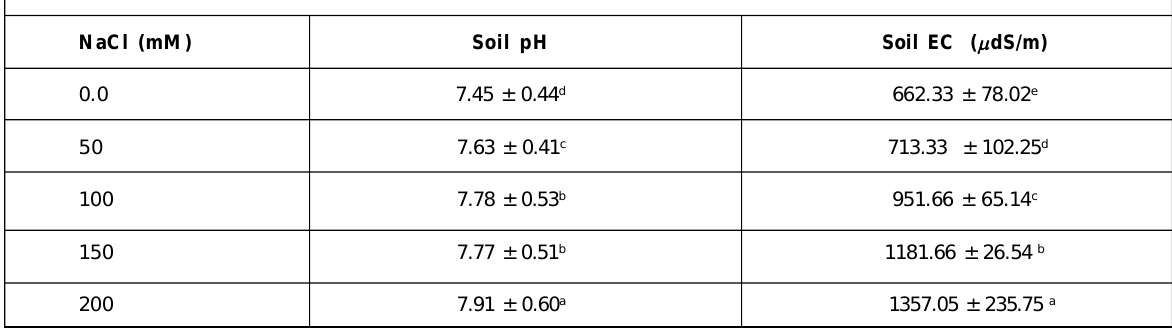
Table 2: Impact of different concentrations of NaCl on soil pH and soil electrical conductivity in Phaseolus vulgaris L.